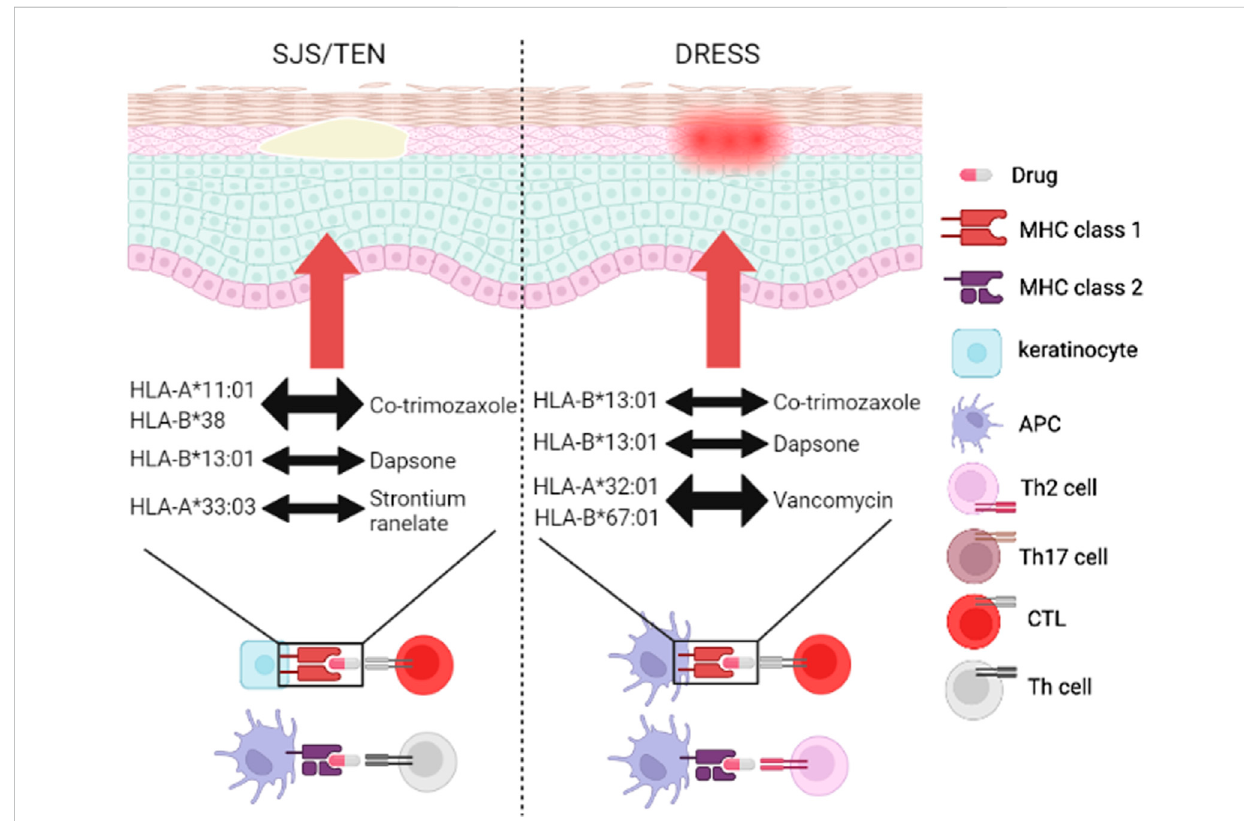
FIGURE 1 Genetic association of SCARs between HLA and drugs. The drugs (antibiotics or AODs) trigger DHRs through MHC/drug/TCR complex. SJS/TEN mainly 694 started immune mechanism by HLA/drug/CTLs and HLA/drug/Th cells, while DRESS mainly 695 started immune mechanism by HLA/drug/ CTLs and HLA/drug/Th2 cells. Co-trimozaxole can induce 696 SJS/TEN and DRESS through binding to HLA-A*11:01/HLA-B*38 and HLA-B*13:01, 697respectively. Dapsone caninduce SJS/TEN andDRESS throughbindingto HLA-B*1301. 698VancomycincaninduceDRESS bybindingto HLA- A*32:01 and HLA-B*67:01. SR can activate 699 SJS/TEN through binding to HLA-A*33:03. Abbreviations: AOD, anti-osteoporotic drug; APC, antigen- presenting cell; CTL, cytotoxic T 701 lymphocyte; DHR, delayed hypersensitivity reaction; DRESS, drug reaction with eosinophilia and 702 systemic symptoms; HLA, human leukocyte antigen; MHC, major histocompatibility complex; SJS, 703 Stevens-Johnson syndrome; TCR, T cell receptor; TEN, toxic epidermal necrolysis; Th cell, T helper 704